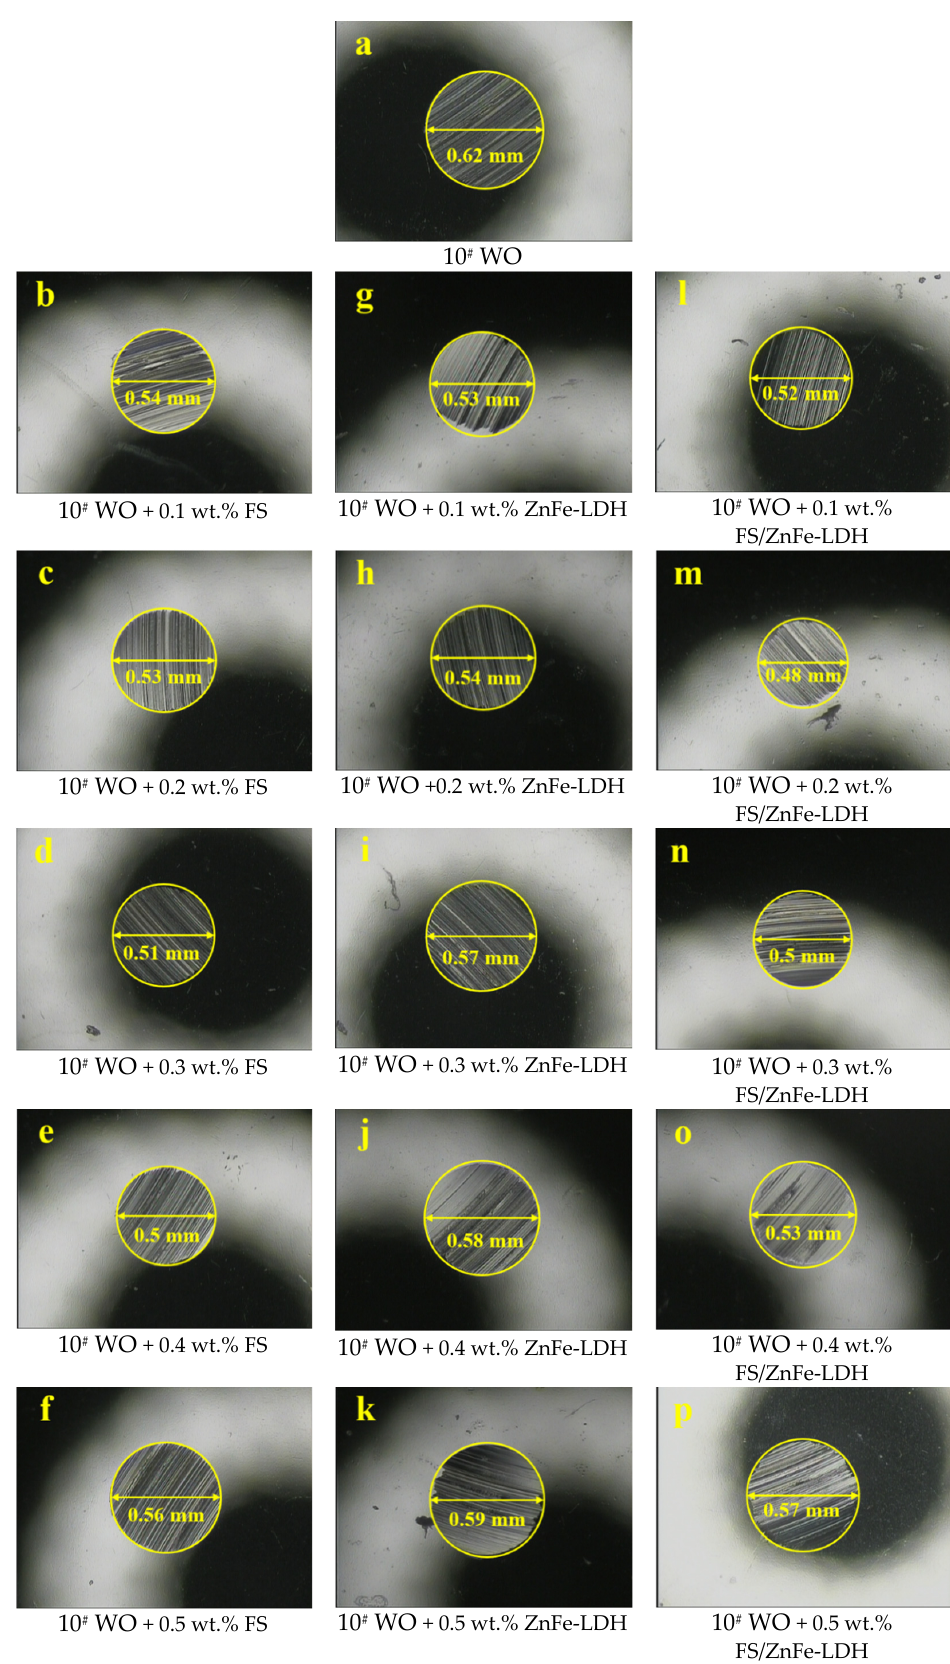
Figure 7. The morphology of the lower test ball wear